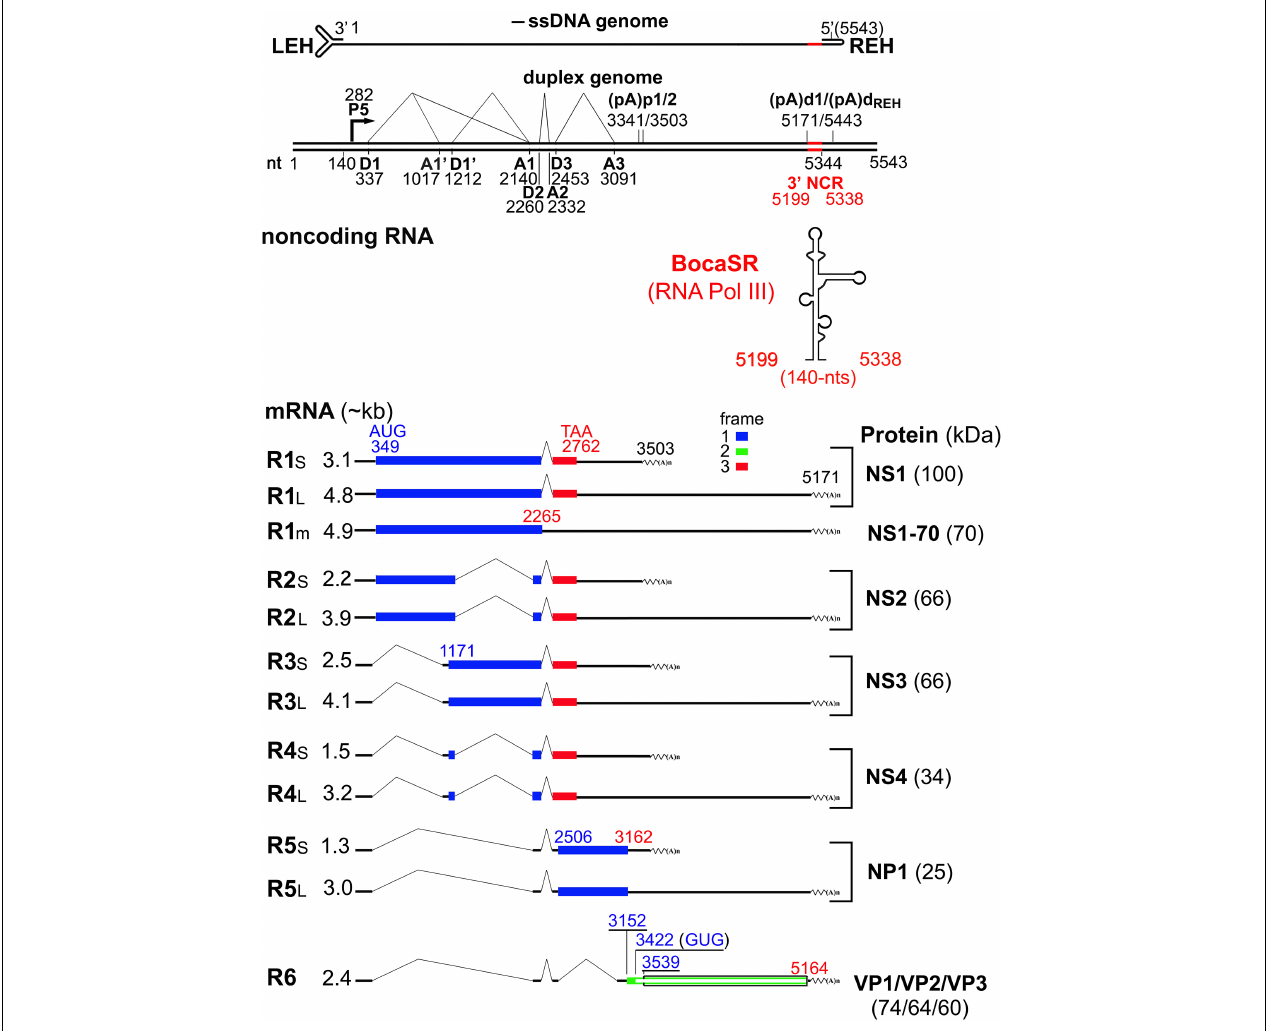
FIGURE 2 | Transcription map of HBoV1. The major transcription landmarks including the terminal repeats (LEH and REH), promoter (P), splice donors (D) and acceptors (A), and (pA)p and (pA)d sites, are depicted. All identified mRNA transcripts are listed below the map (designated R1 to R6), with their respective sizes shown on the left and the detected molecular weight of the expressed proteins shown to the right. Different ORFs are illustrated in blue, red or green colors. The expressed non-coding RNA (BocaSR) is diagrammed with the size. NCR, non-coding